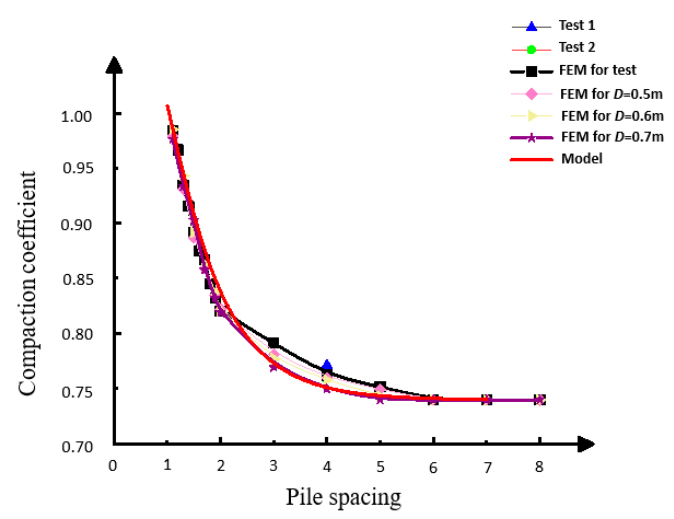
Figure 9. The relationship between the compaction coefficient at the centroid and n.